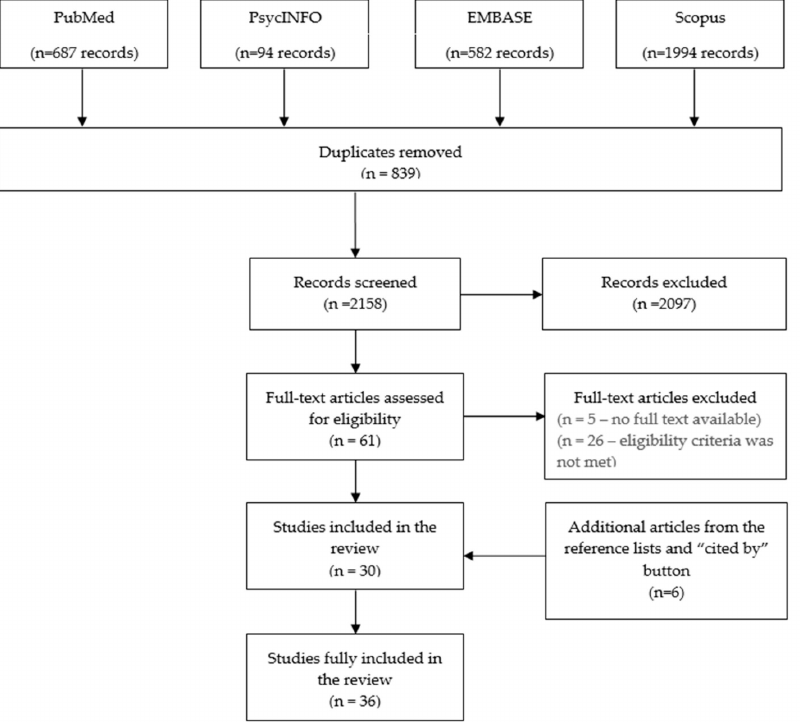
Figure 1. Review